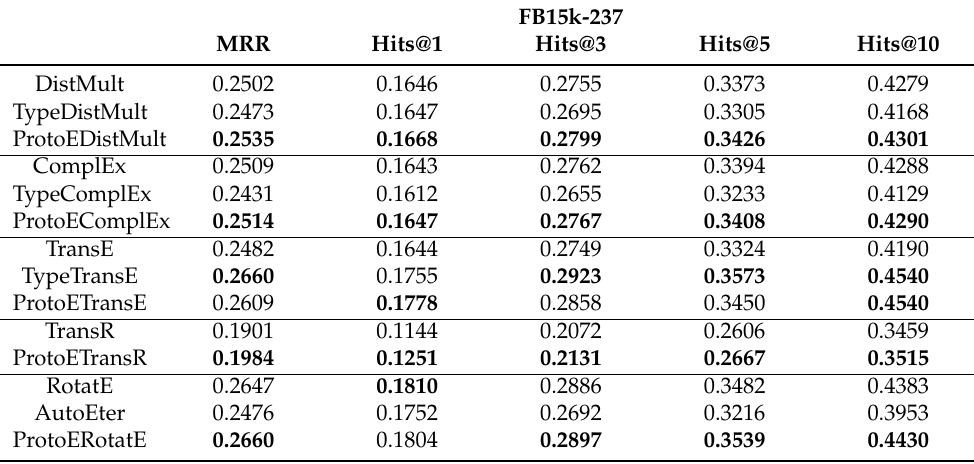
Table 2. Experimental results for FB15k-237. Best values are indicated in